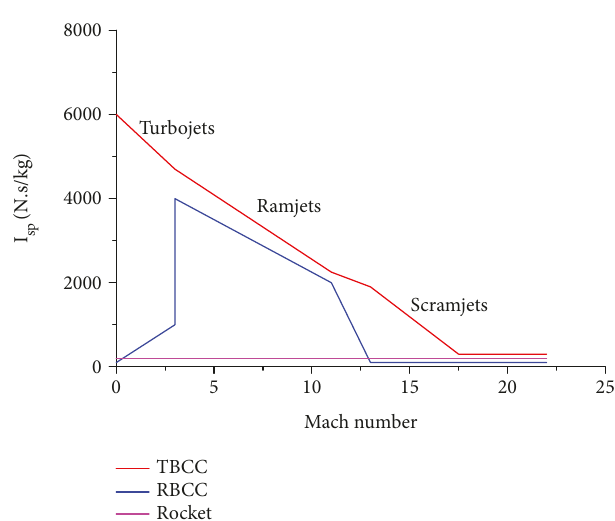
Figure 1: Speci fi c impulse comparison between di ff erent propulsion types with Mach number variation